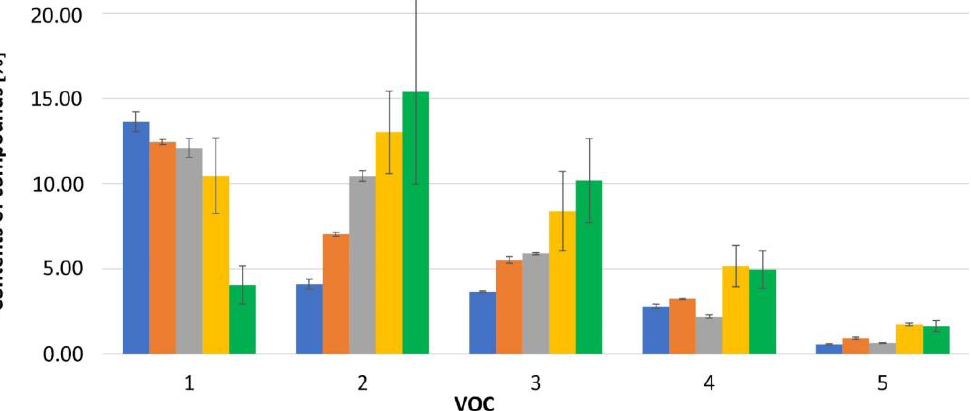
Figure 1. Compare VOC percentages for samples stored refrigerated and frozen for 1 month and 3 months. Compounds: 1: 4-(cyclopent-1-enyl)benzoic acid methyl ester ( 74 ), 2: bicyclogermacrene ( 49 ), 3: alloaromadendrene ( 40 ), 4: germacrene D ( 47 ), 5: selina-5,11-